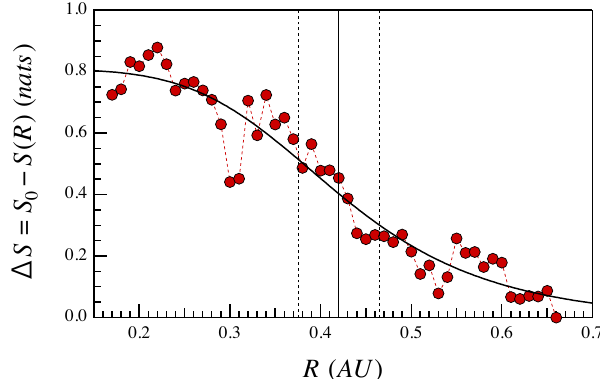
Figure 9. The behavior of the entropy reduction/variation ∆ S ( R ) as a function of the radial distance R . Solid line is best fit using the Hill function. The vertical solid and dashed lines refer to the transition region R = [ 0.420 ± 0.045 ]